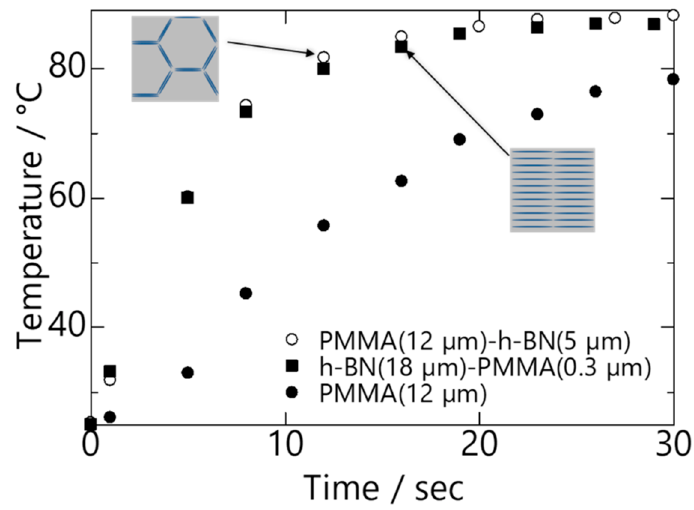
Figure 7. Comparison of temperature change against time for PMMA, layer-oriented PMMA/hBN, and percolation-oriented hBN/PMMA composites.